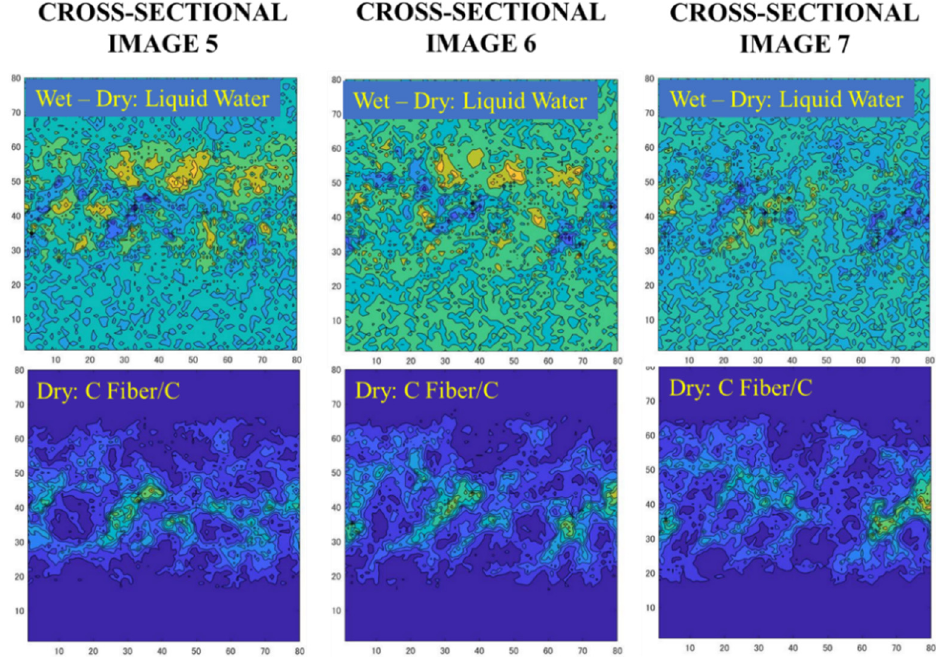
Figure 7. Imaging liquid water in cross-sections 5–7, together with the image of the dry sample.